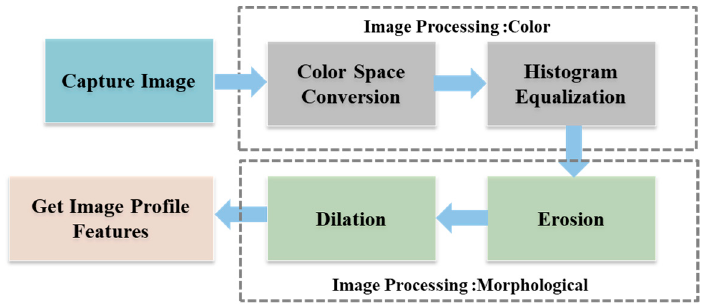
Figure 4. Flow of image processing.